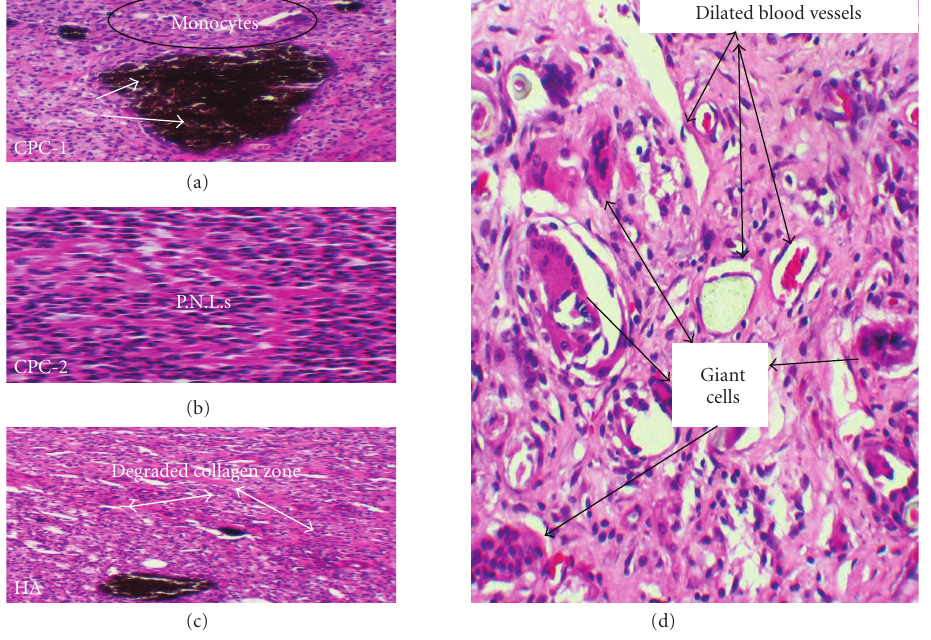
Figure 5: Tissue reactivity to implanted materials at 7 days. (a) this shows mild inflammatory reaction mediated by mononuclear monocytes in response to the implanted CPC-1 (arrows). (b) Implanted CPC-2 at 7 days shows a moderate inflammatory reaction mediated by mononuclear cells. (c) Implanted HA at 7 days exhibits an area of collagen degradation (arrows). (d) Example of the inflammatory reaction characterized by small dilated blood vessels and presence of giant cells observed in response to all the implanted materials (CPC1 shown) H&E X200.